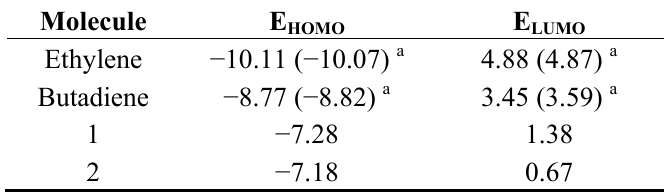
Table 1. HOMO and LUMO energies (in eV) of ethylene, 1,3-butadiene and the fragments 1 and 2 .